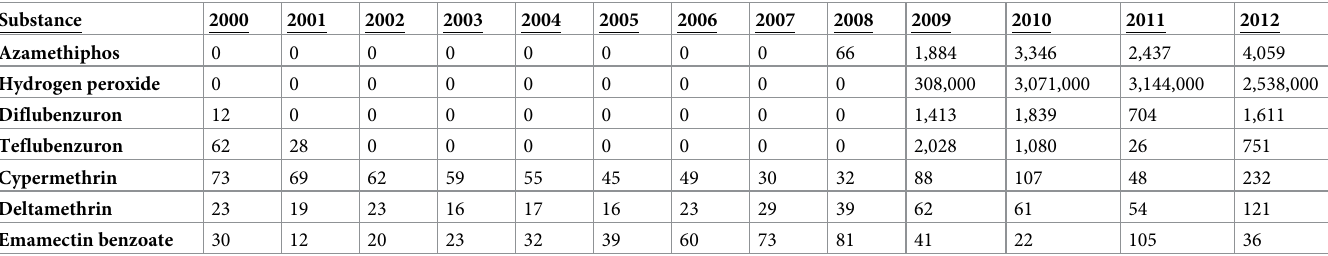
Table 1. Consumption of medicines,